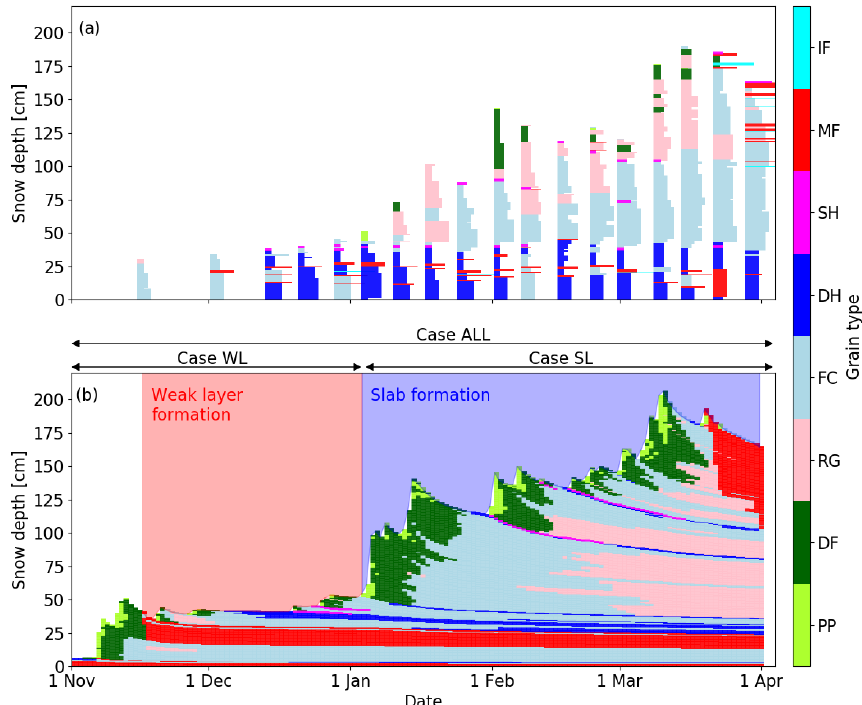
Figure 1. (a) Manually observed snow profiles at the Weissfluhjoch field site for the winter season 2016–2017. (b) Reference run simulated with SNOWPACK for the winter season 2016–2017 at the WFJ field site above Davos, Switzerland. Shown is the temporal evolution of simulated snow stratigraphy. Colors indicate grain type, i.e., precipitation particles (PP), decomposing and fragmented precipitation particles (DF), rounded grains (RG), faceted crystals (FC), depth hoar (DH), surface hoar (SH), melt forms (MF) and ice formations (IF). The red colored period refers to weak layer formation, the blue colored period to slab formation. Arrows indicate different scenarios for which uncertainties were introduced into meteorological model